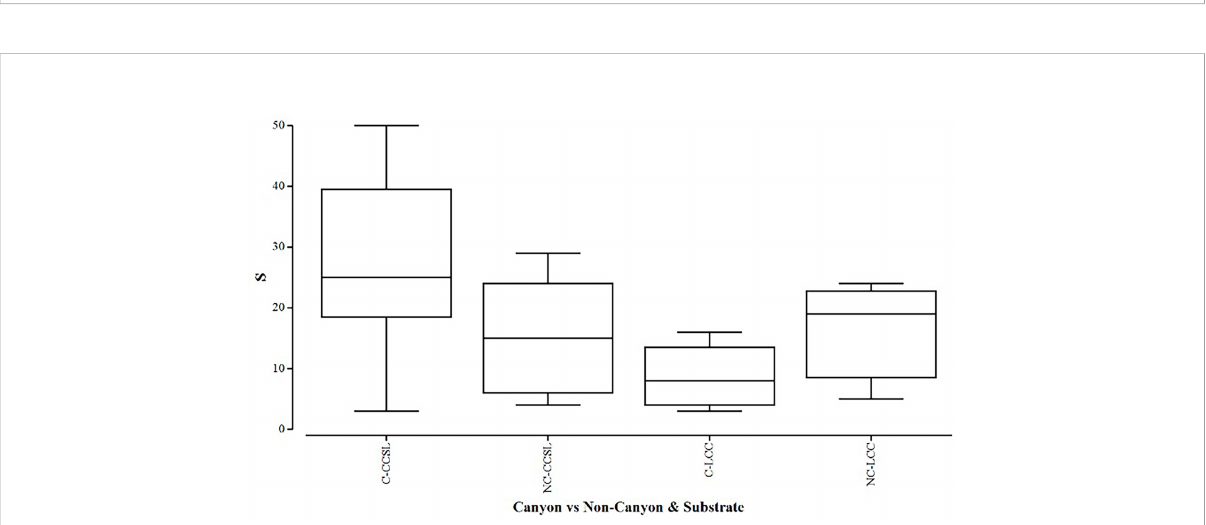
FIGURE 4 Box plot showing the species richness represented within each canyon (C) vs. non-canyon (NC) substrate type group: where CCSL, represents Calcareous clay, siltstone, limestone; and LCC, Limestone, Calcareous